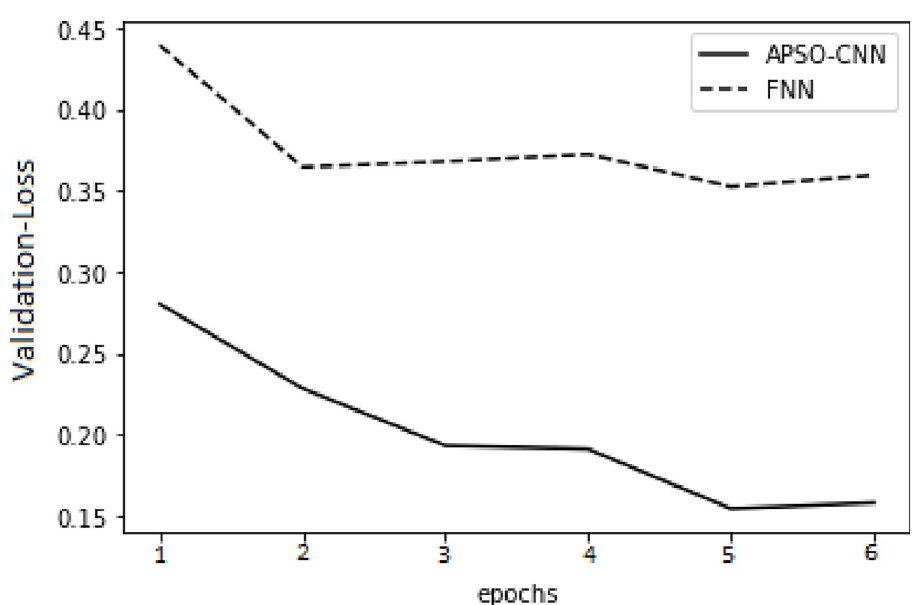
Fig 12. APSO–CNN and FNN algorithms’ loss function validation sets.